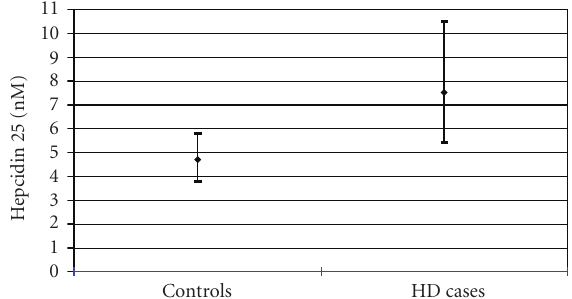
Figure 2: Hepcidin-20 in controls and HD patients. Data presented as geometric mean with 95% confidence interval.